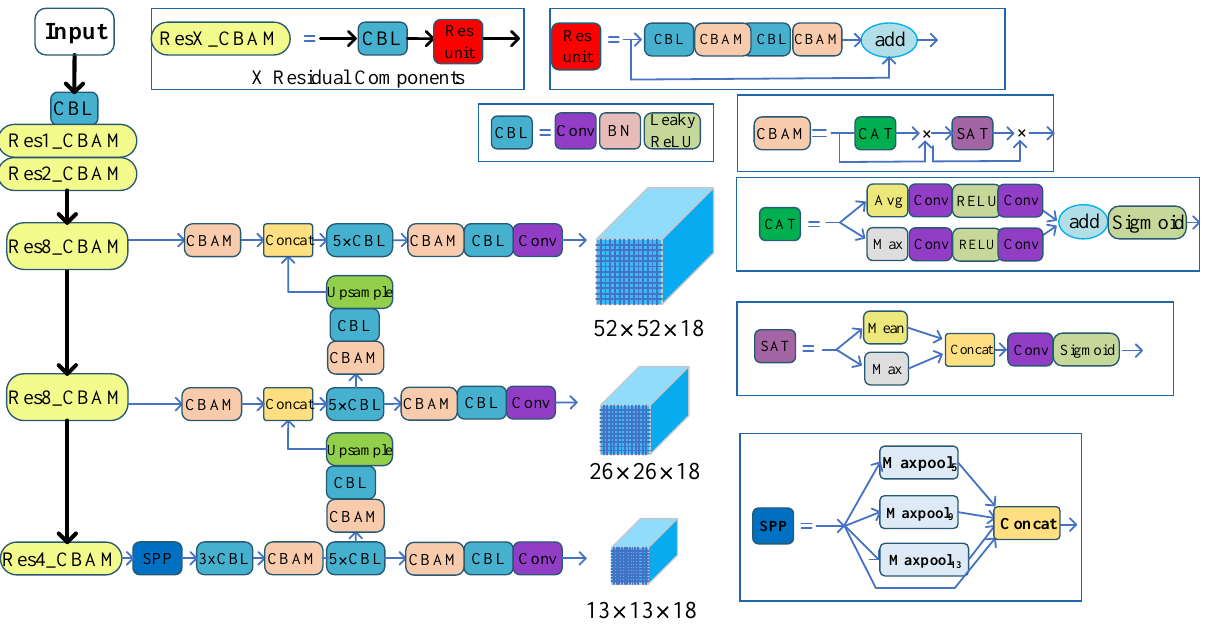
Figure 5. The pipeline of the proposed YOLOv3-SC. Here, we should note that the 5, 9, 13 in the Maxpool 5 , Maxpool 9 , Maxpool 13 indicate the pooling kernel size of the maxpool